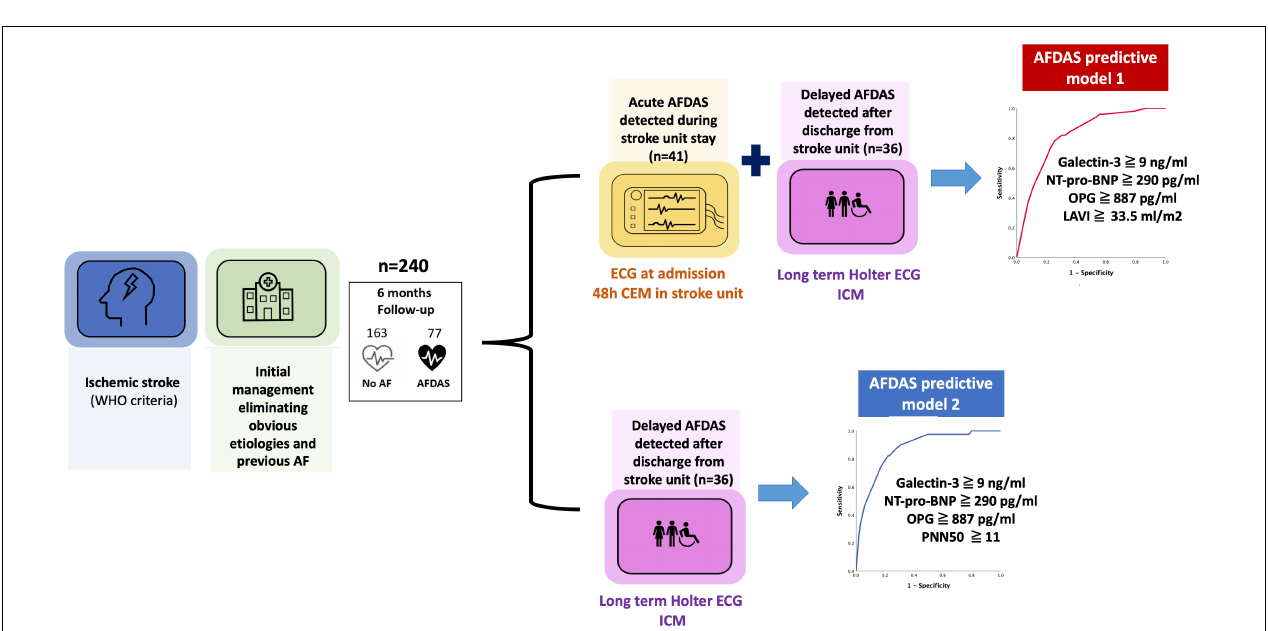
FIGURE 2 | ROC curve for models 1 and 2. Model 1 associates galectin-3 = 9 ng/ml; NT-pro-BNP ≥ 290 pg/ml; OPG ≥ 887 pg/ml and LAVI ≥ 33.5 ml/m 2 for all AFDAS prediction ( n = 240). Model 2 associates galectin-3 ≥ 9 ng/ml; NT-Pro-BNP ≥ 290 pg/ml; OPG ≥ 887 pg/ml and pNN50 ≥ 11 for AFDAS occurring after a stay in the stroke unit: AUC, area under the curve. OPG, osteoprotegerin.